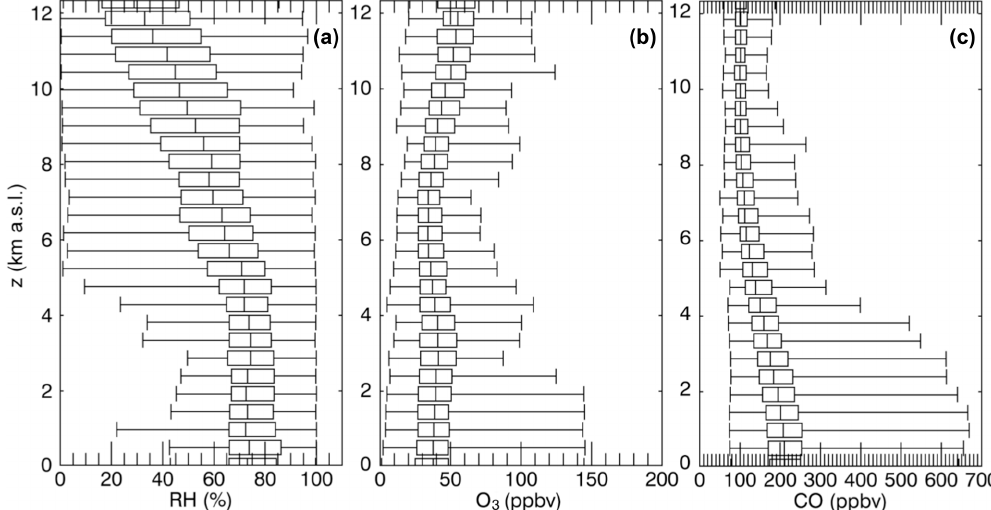
Figure 1. Boxplots showing first percentile, first quartile, median, third quartile and 99th percentile of (a) relative humidity (RH; limited to 100%), (b) ozone (O 3 ) and (c) carbon monoxide (CO) between 0 and 12km altitude from IAGOS measurements during take-off from and landing to TPE over the time periods 1 July to 31 October in 2012–2016.